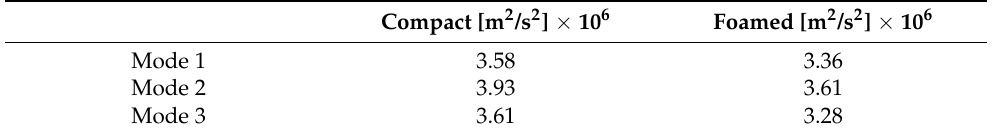
Table 8. Estimated specific elastic